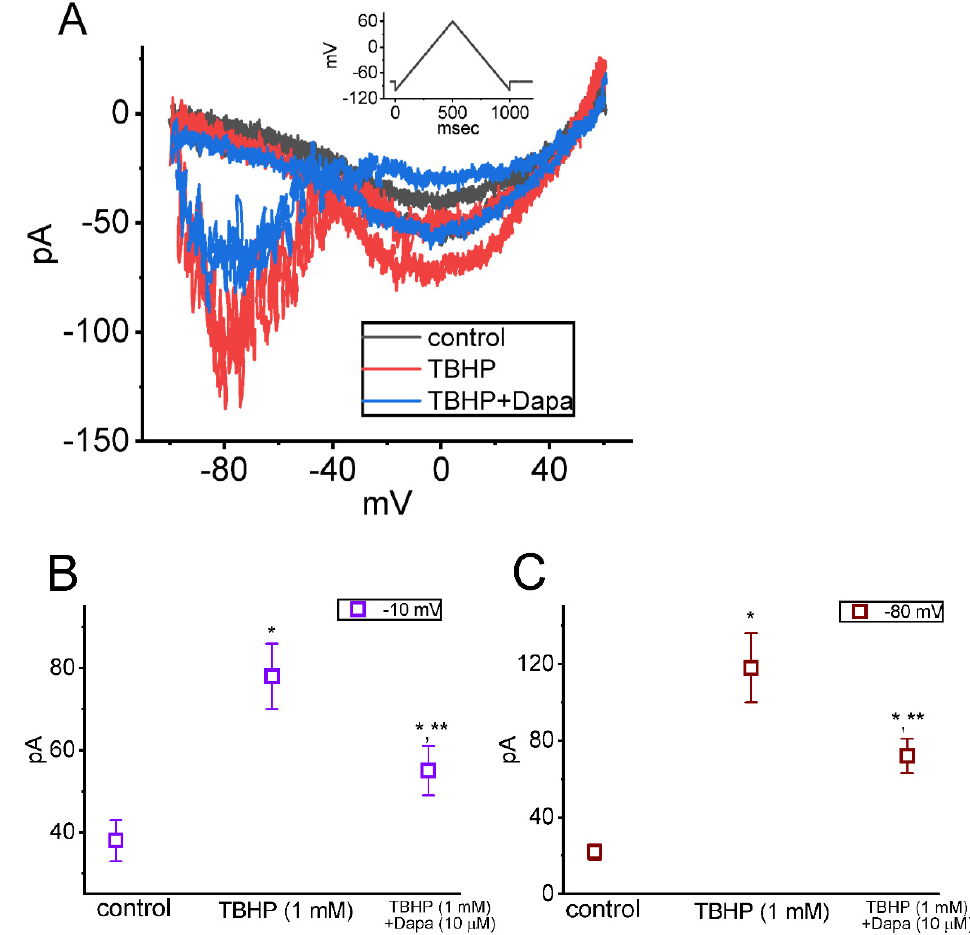
Figure 4. Effect of t-butyl hydroperoxide (TBHP) and TBHP plus dapagliflozin (Dapa) on Hys (V) loop of I Na(P) in pituitary GH 3 lactotrophs. ( A ) Representative current traces activated by the triangular V ramp for a duration of 1 s (or ramp speed of 320 mV/s) (as indicated in inset). Current trace shown in black color is control (i.e., neither TBHP nor Dapa), while that in red or blue color was respectively obtained in the presence of 1 mM TBHP, or 1 mM TBHP plus 10 μ M Dapa. Two red and blue traces indicate current trajectories, respectively, activated by the upsloping and downsloping end of the V ramp . In ( B , C ), summary graphs, respectively, demonstrate effects of TBHP or TBHP plus Dapa on the amplitude of I Na(P) at the upsloping ( − 10 mV) and downsloping ( − 80 mV) ends of triangular V ramp (mean ± SEM; n = 7 for each point). * Significantly different from control ( p < 0.05), and ** significantly different from TBHP (1 mM) alone group ( p < 0.05).